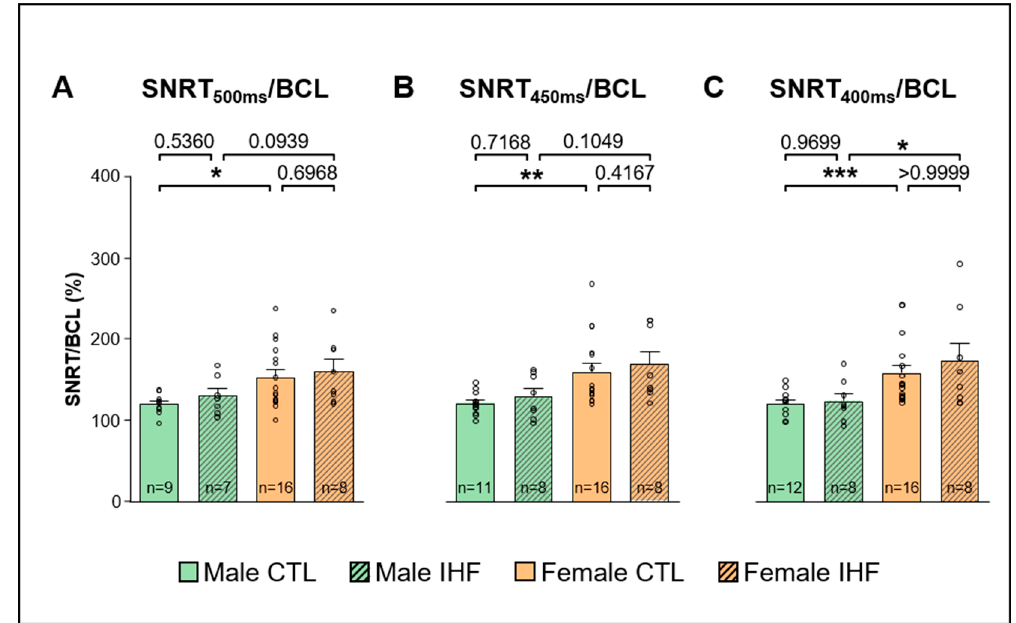
Figure 5. Corrected Sinus Node Recovery Time (SNRT/BCL). ( A ), SNRT/BCL at a pacing cycle length of 500 ms. ( B ), SNRT/BCL at a pacing cycle length of 450 ms. ( C ), SNRT/BCL at a pacing cycle length of 400 ms. CTL , control animals without ischemic heart failure; IHF , animals with ischemic heart failure. Bar graphs represent Mean + SEM, grey circles represent data of individual pigs. Mann-Whitney-U Test. * p < 0.05; ** p < 0.01; *** p < 0.001.